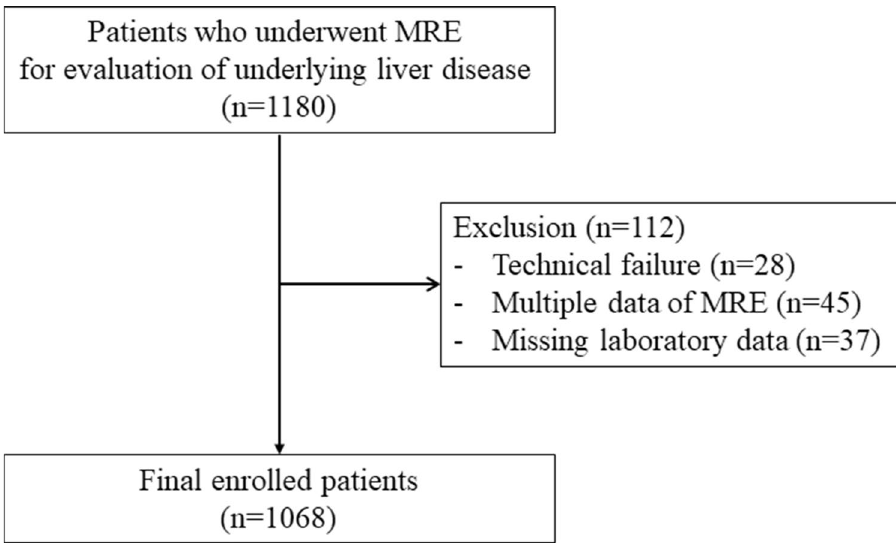
Figure 1. Flow diagram of patient selection, inclusion and exclusion criteria for the study. MRE = MR